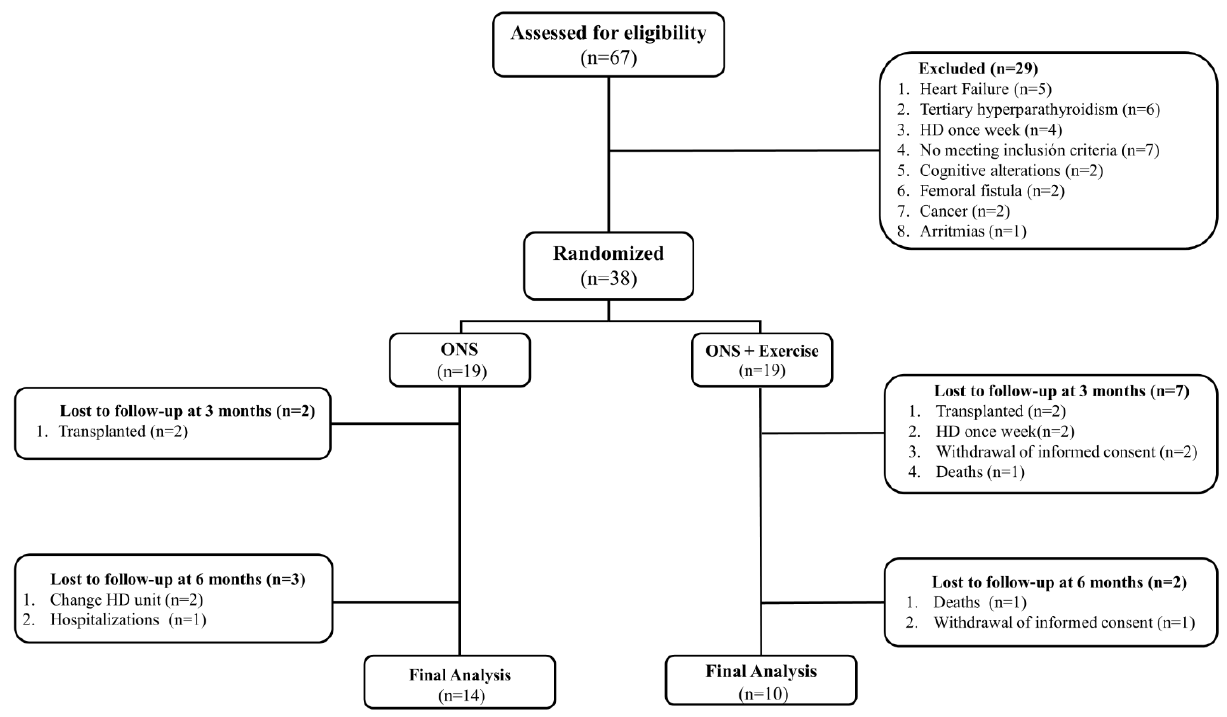
Figure 1. Sreening, randomization and follow-up according to the CONSORT diagram.